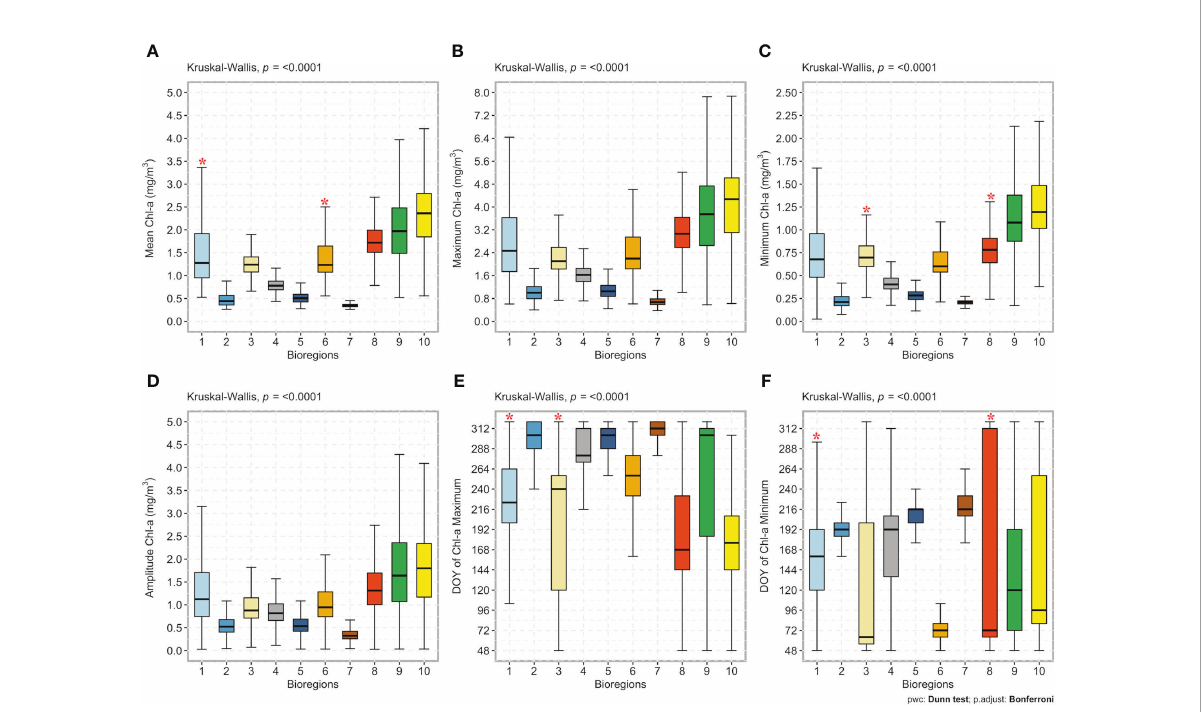
FIGURE 7 Box plots of the bioregions (1 to 10; x-axis) against (A) the annual mean chlorophyll-a concentration (mg/m 3 ), (B) the annual chlorophyll-a maximum (mg/m 3 ), (C) the annual chlorophyll-a minimum (mg/m 3 ), (D) the annual amplitude (i.e., the difference between the annual maximum and the annual average; mg/m 3 ), (E) the timing of the bloom maximum (day of the year - DOY), and (F) the timing of the bloom minimum (DOY; y-axis). The line in the middle of each box represents the median. The top and bottom limits of each box are the 25th and 75th percentiles, respectively. The lines extending above and below each box (i.e., whiskers) represent the full range of non-outlier observations for each variable beyond the quartile range. The Kruskal-Wallis H test results are shown on the top of each fi gure (A – E) . A signi fi cant result (p < 0.05) of the Kruskal-Wallis H test implies that at least one bioregion differs from all others. The results of Dunn ’ s multiple comparison test are also shown. Red asterisks * depict bioregions (x-axis) without statistically signi fi cant differences between the climatological input variables (y- axis), whereas no asterisks depict signi fi cant differences at the 95% level (p < 0.05) between bioregions. Note that each box color corresponds to that used in Figure 5 and identi fi es the same